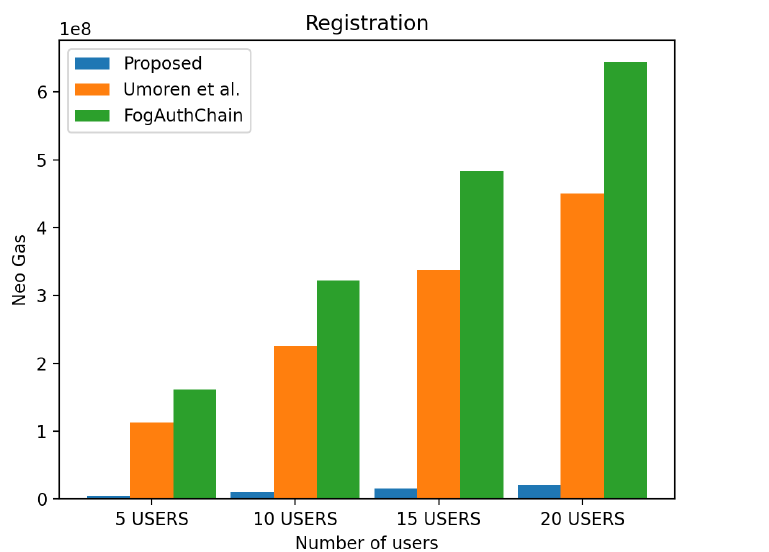
Figure 7. Evaluation of experimental results on registration gas for the proposed system and the existing system [8,16].